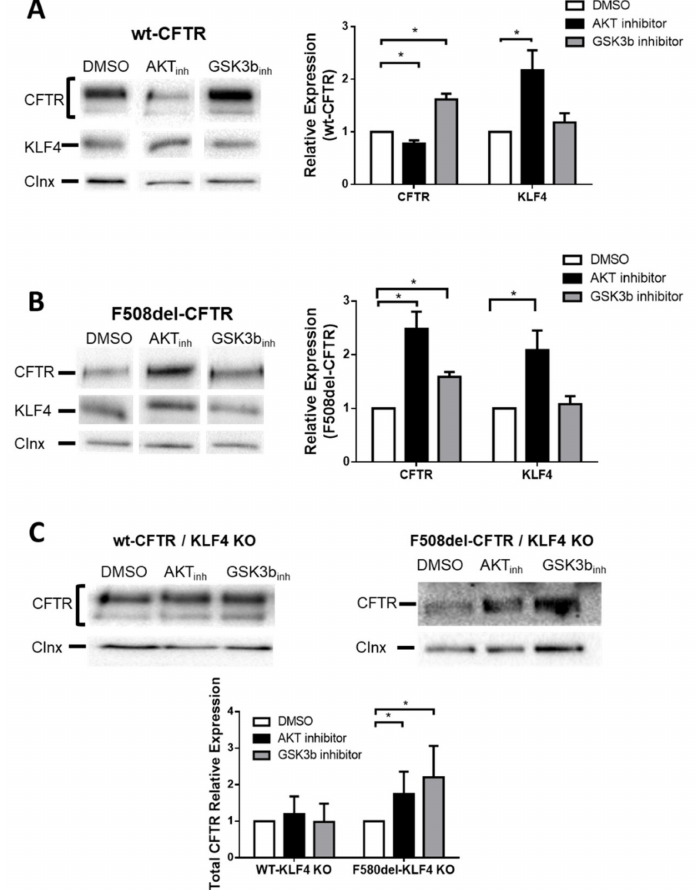
Figure 5. AKT inhibition impacts negatively on wt-CFTR expression and positively on F508del–CFTR, while GSK3 β inhibition impacts positively on both wt- and F508del–CFTR. Representative WB of CFTR and KLF4 expression in wt- ( A ) and F508del–CFTR CFBE ( B ) and their respective KO counterparts ( C ) under DMSO or the inhibitors treatments. Calnexin was used as loading control. Data are normalized to loading control and showed as relative expression (vs. DMSO) (n = 3, unpaired t -test, p <